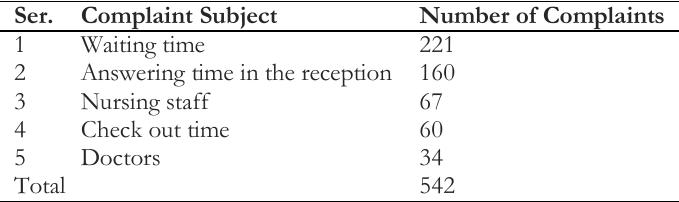
Table 1. Types of patient complaints from the hospital departments in year 2018.